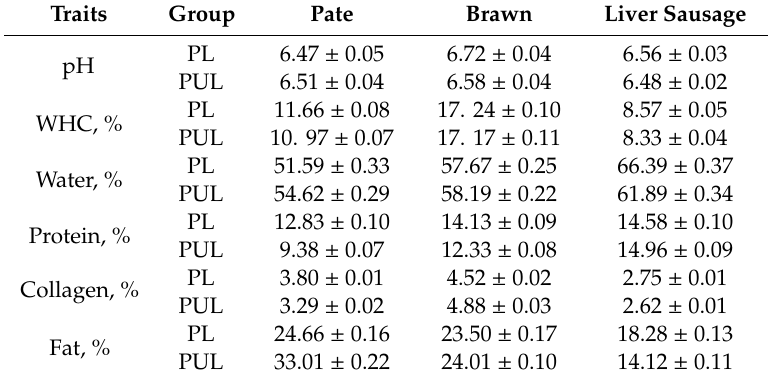
Table 4. Physical indicators and chemical composition of o ff al products depending on pig breed (mean ±